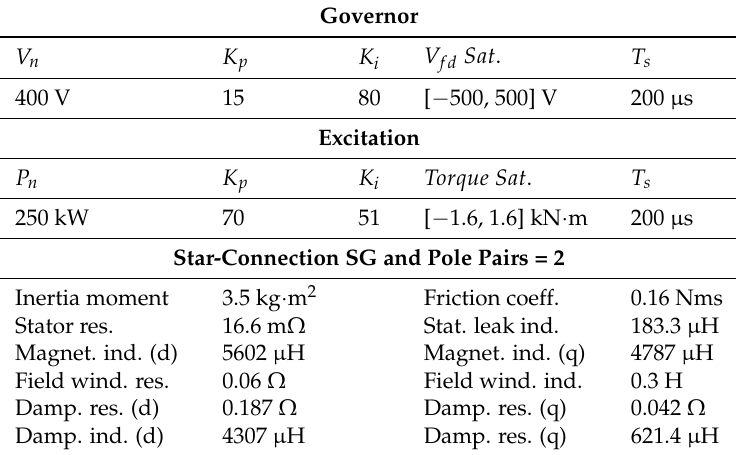
Table 1. Value of the parameters considered in the model for the synchronous generator (SG).